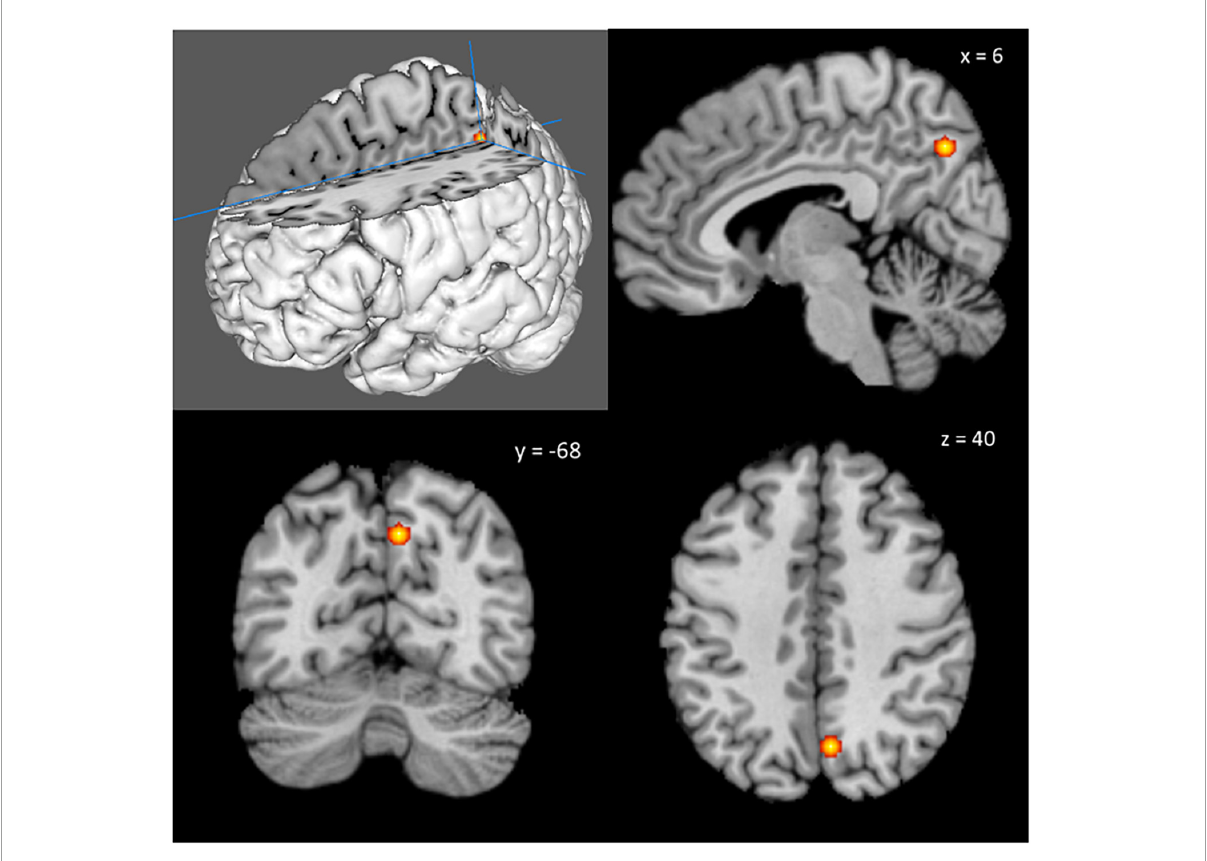
FIGURE3 The right precuneus was significantly activated across studies that investigated food nutrition labels. The peak voxel of the activated cluster was at [6, –68, 40], with ALE value of 1.75 × 10 − 2 and cluster size of 520 mm 3